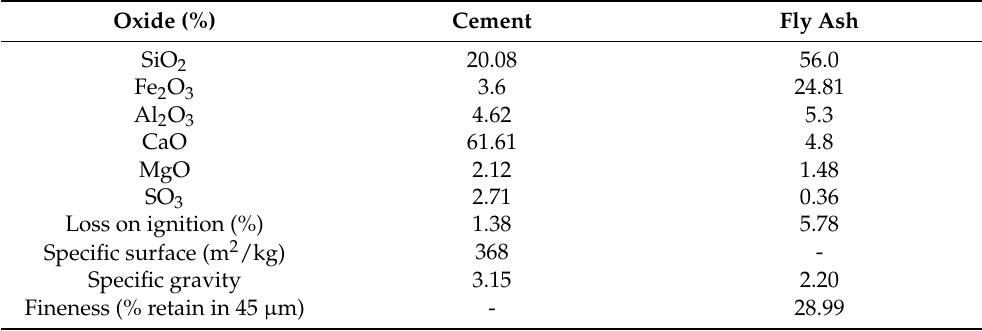
Table 2. Properties of cement and fly ash.